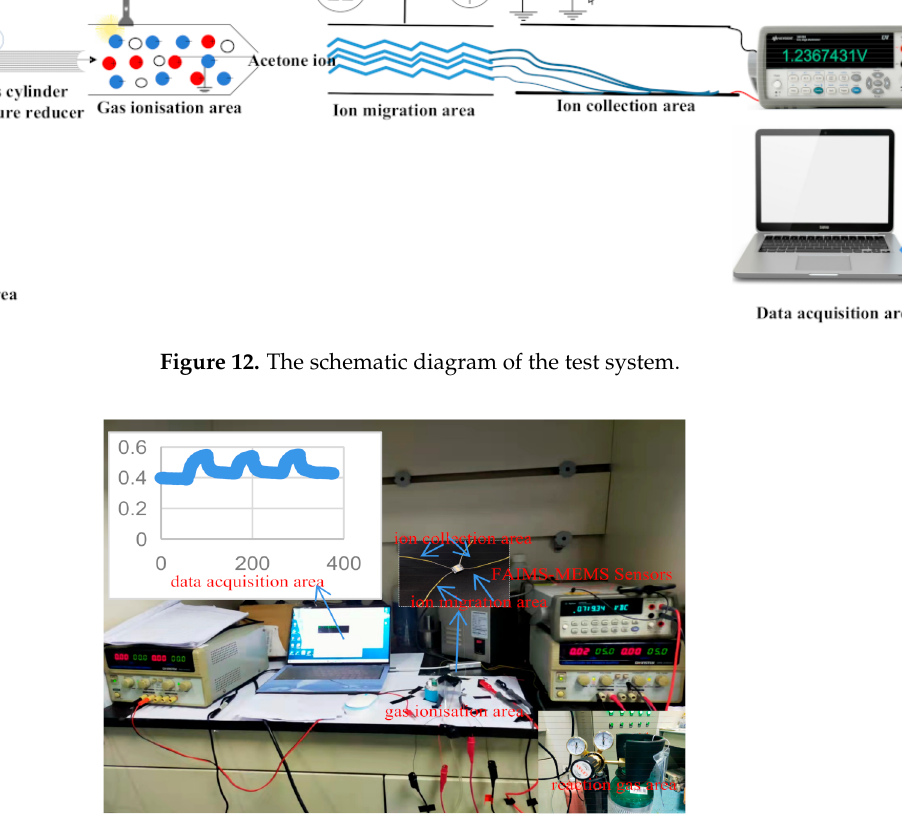
Figure 13. The physical diagram of the test